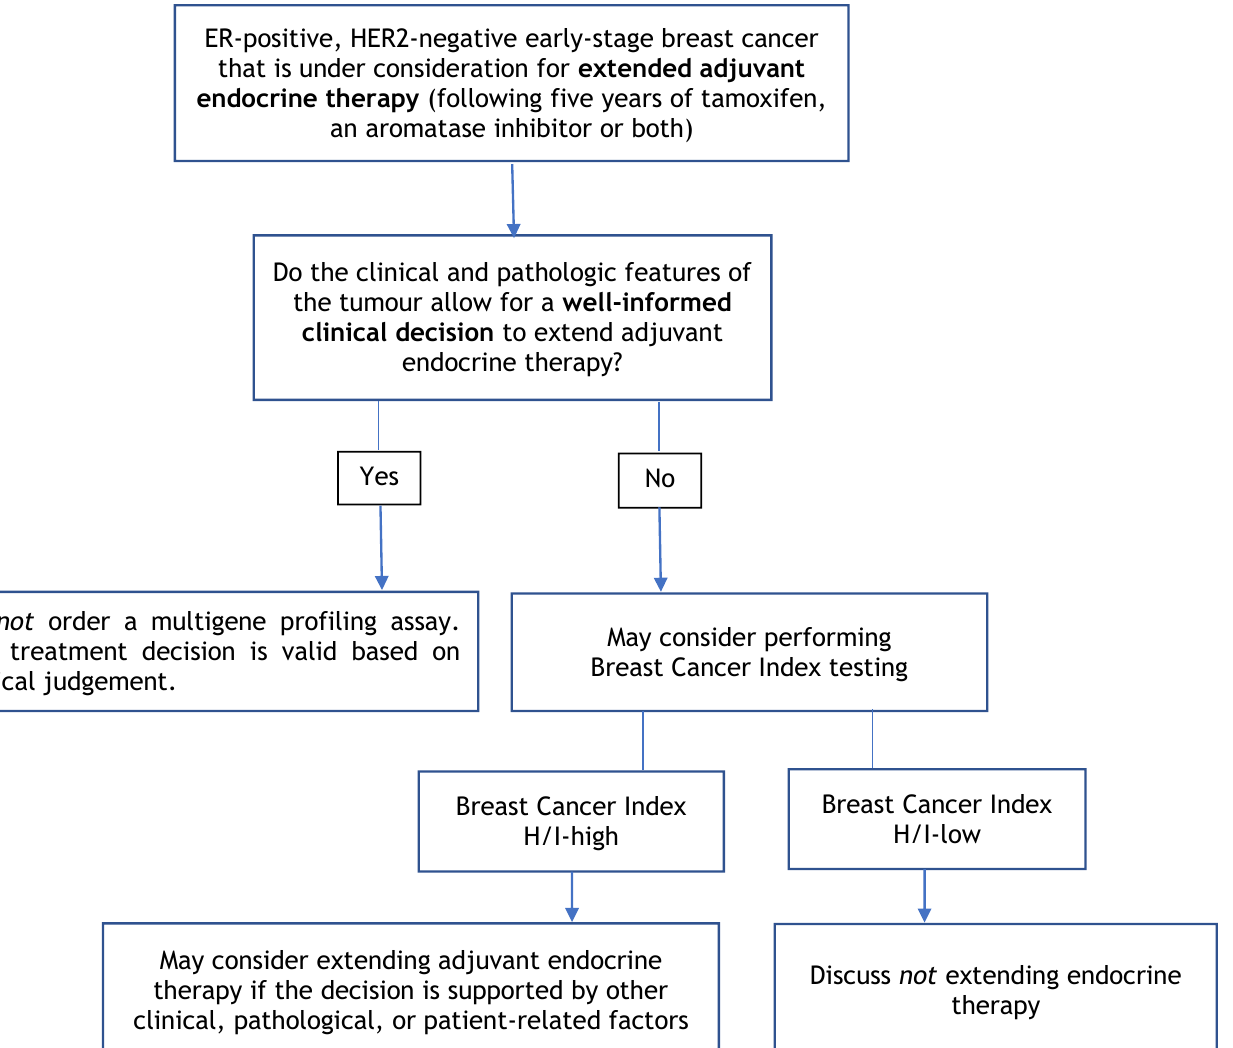
Figure 3. Multigene Profiling Assay Decision Tree for Extended Adjuvant Endocrine Therapy.